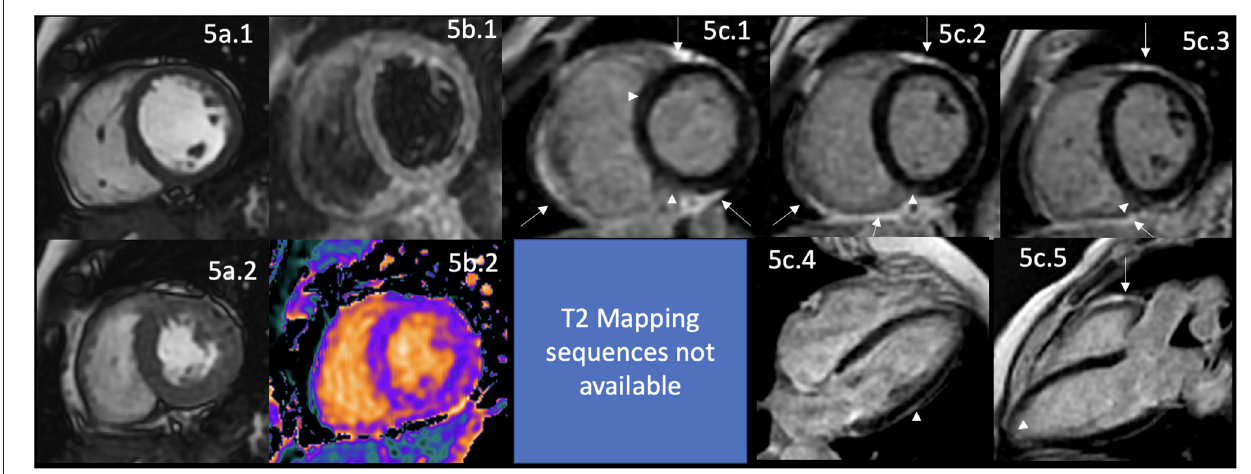
FIGURE 5 | CMR findings in SSc. A panel figure demonstrates varying findings by a comprehensive CMR study at 1.5 Tesla scanner of SS. (a) SSFP sequence still cine images in short-axis view at the mid-ventricular level in end-diastole (a.1) and end-systole (a.2) shows normal global and regional functions of both ventricles, LVEF 57% and RVEF 56%. (b.1) T2-W STIR sequence in short-axis view at the mid-ventricular level of normal myocardium and myocardial/skeletal muscle ratio. (b.2) T1 mapping with a native T1 of 998ms (mildly increase) and a calculated ECV of 32% (mildly increase). (c.1–5) LGE PSIR sequence. (c.1–3) Short-axis views at basal (c.1) , mid (c.2) , and apical (c.3) levels, and long-axis views in 4-chambers (c.4) and 3-chambers (c.5) . The arrowheads in these images show areas of focal fibrosis as mid-wall LGE of the anteroseptal segment in (c.1) and the subepicardium of the inferior segment in (c.1–3) in the basal and mid anterolateral segments in (c.4)